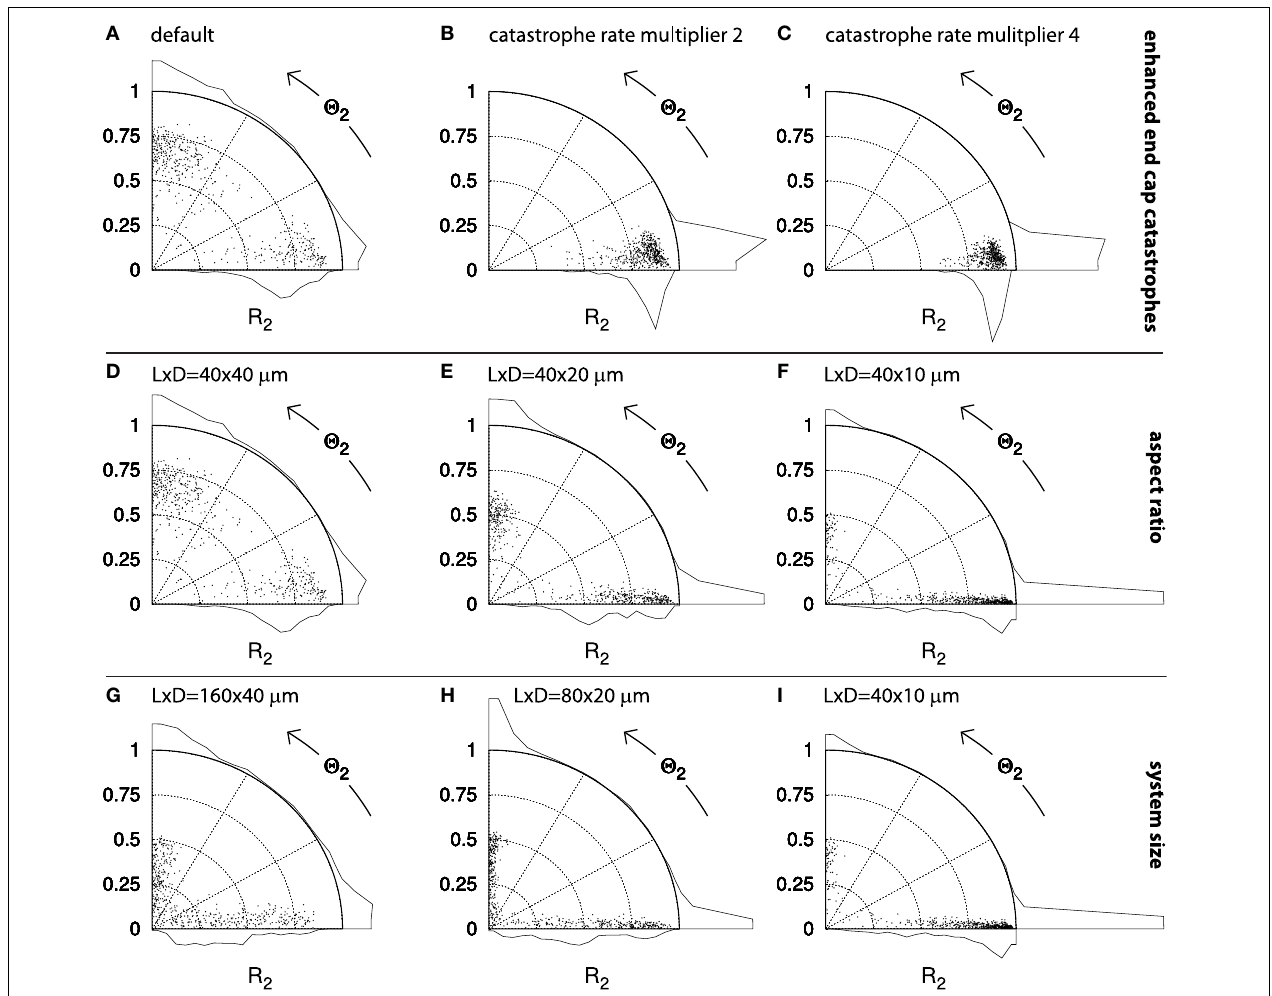
4.2.5). The default cylinder has length L = 40 μ m and diameter D = 40 μ m. Simulations were performed using default parameters and the results were analyzed at t = 20h. (A–C) : Sequence with increasing multipliers for the spontaneous catastrophe rates on the cylinder end caps: 1 ( (A) ; default), 2 (B) , and 4 (C) . D–F : Sequence of different aspect ratios, obtained by decreasing the cylinder diameter: D = 40 , 20 , 10 μ m, respectively. G–I : Sequence of decreasing absolute system sizes: ( L , D ) = ( 160 , 40 ) ; ( 80 , 20 ) ; ( 40 , 10 )μ m,